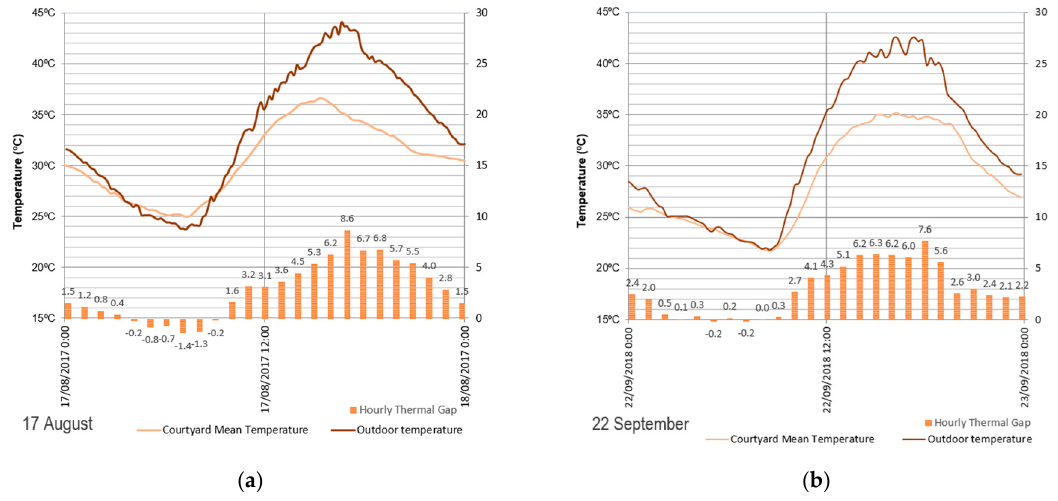
Figure 2. Outdoor and Courtyard temperature and Thermal Gap without shading device ( a ) Courtyard A in Córdoba; ( b ) Courtyard B in